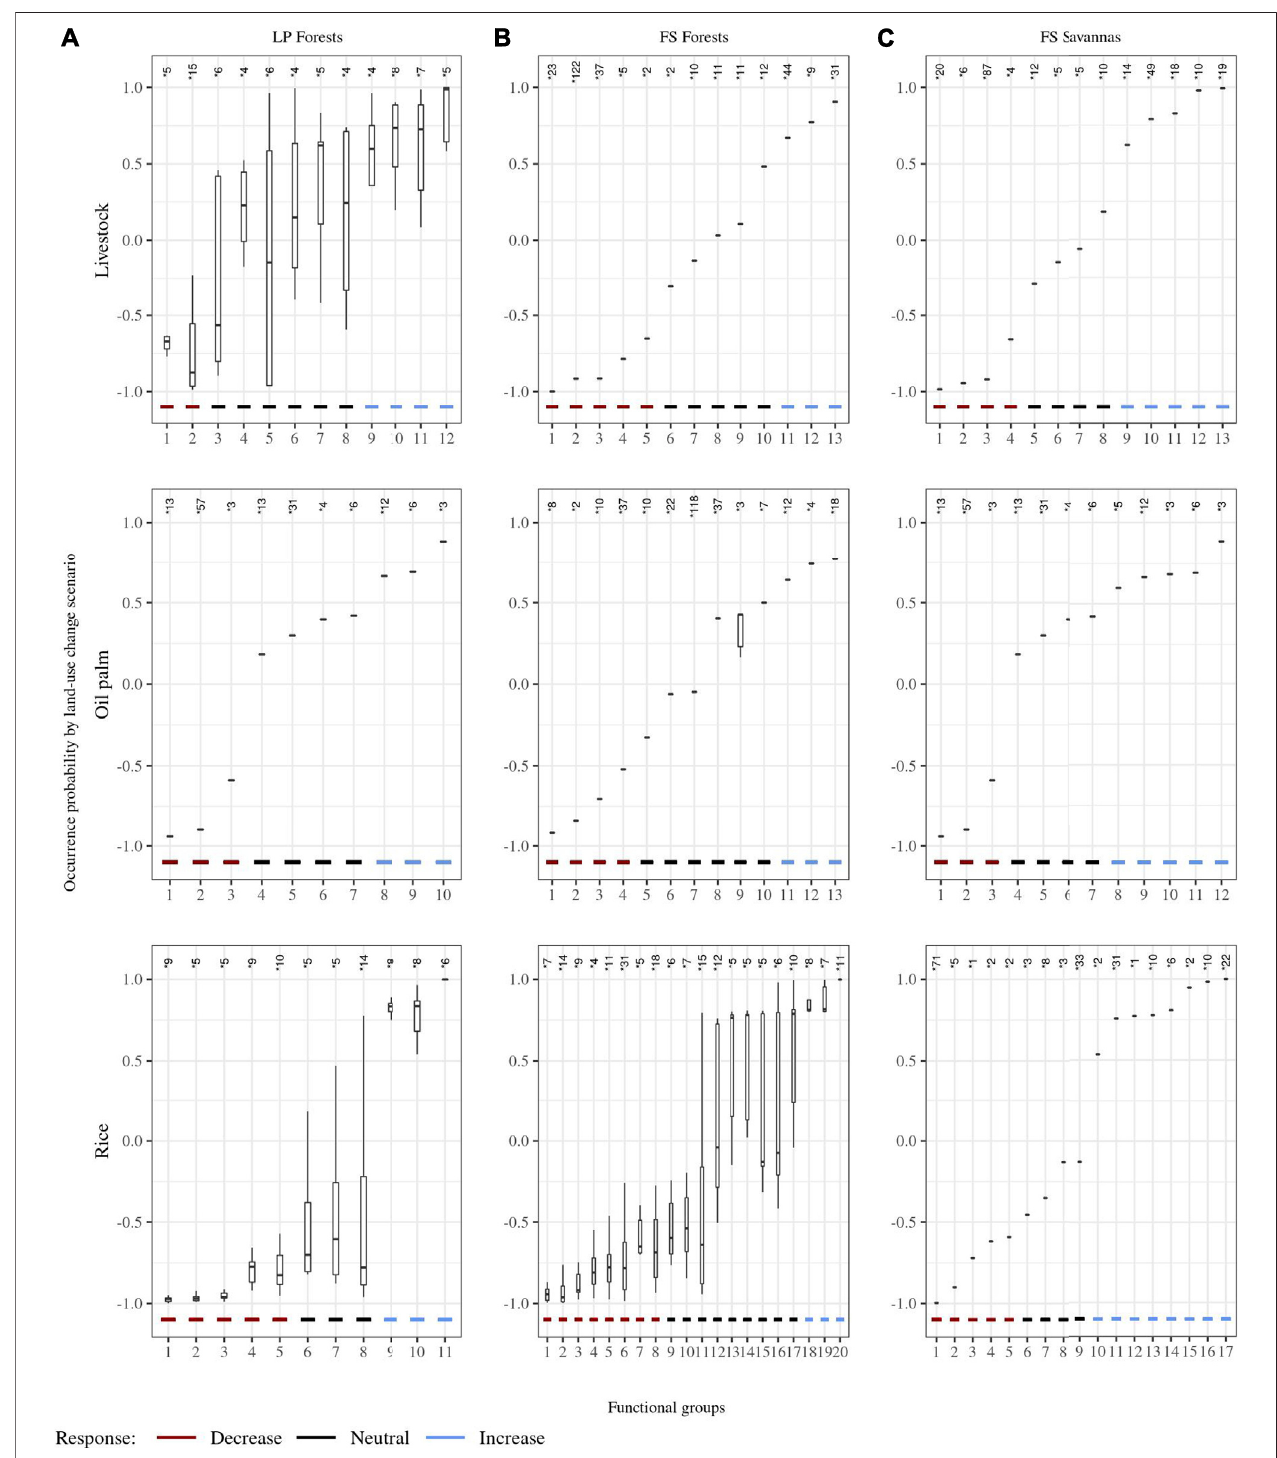
FIGURE5| Responsefunctionalgroupstoland-usechangescenarios.The x -axisrepresentsthefunctionalgroupsbyland-usechangeandthe y -axistherangeof theirpartialresponsestochange.Responsesnearestto1and-1meangroupswithspecieswithahighprobabilitytoincreaseordecrease,respectively,theiroccurrence probability after the change. * Number of species by group. (A) . Land-use change scenarios from forests to agricultural covers in the Llanos piedmont (LP) landscape; (B) . land-use change scenariosfrom forests to agricultural covers inthe fl ooded savanna (FS)landscape; (C) . land-use change scenarios from natural savannas to agricultural covers in the FS